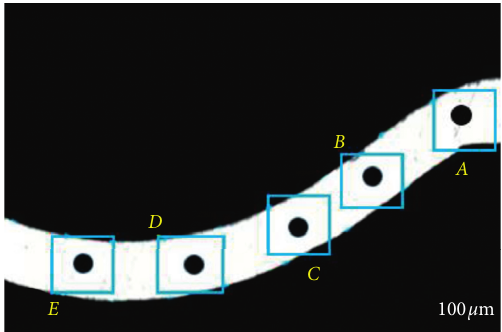
Figure 11: Measurement locations of